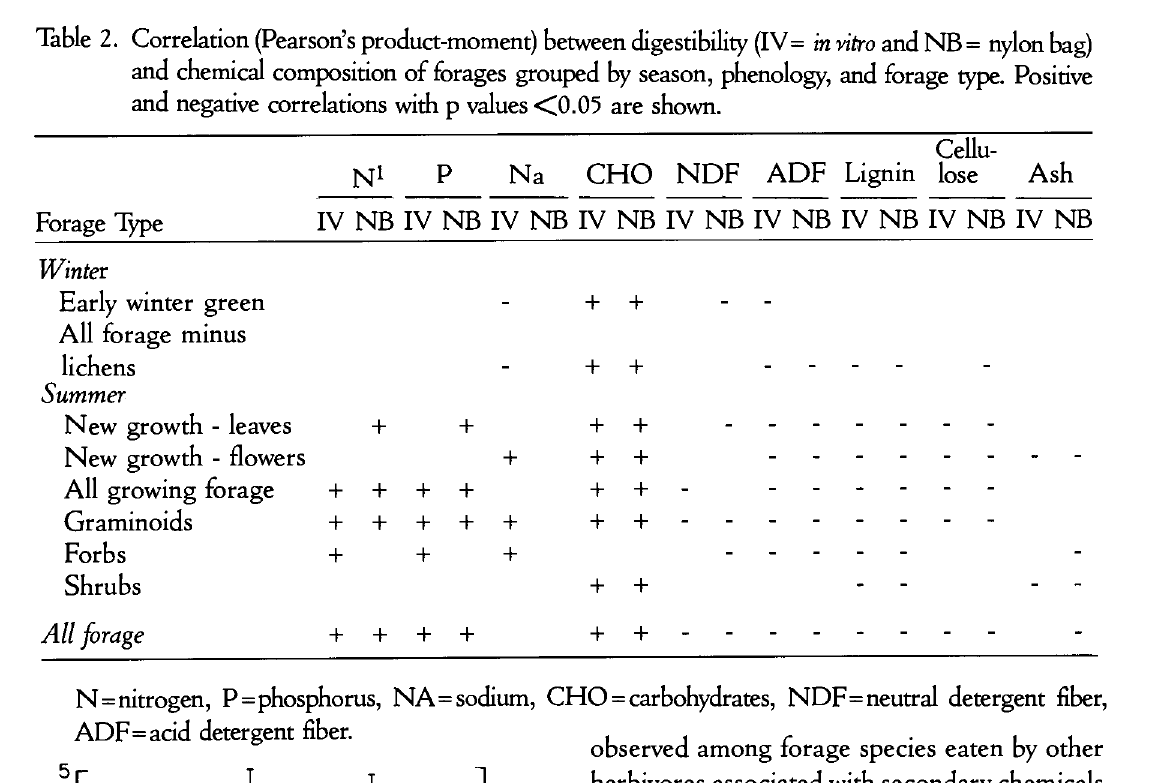
Table 2. Correlation (Pearson's product-moment) between digestibility (IV= in vitro and NB= nylon bag) and chemical composition of forages grouped by season, phenology, and forage type. Positive and negative correlations with p values <0.05 are shown.